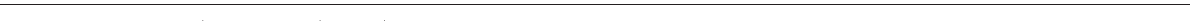
FIGURE 3 | Ly6G − F480 + CD11c − Ly6C + MHC II + cells (A–C) . The total number of neutrophils (D) , inflammatory monocytes (E) , and infiltrating macrophages (F) from days 1 and 3 were calculated according to their percentages of the total population and the total number of cells collected in each lung. @ denotes P ≤ 0.05 between coinfected and uninfected groups. # denotes P ≤ 0.05 between coinfected and influenza groups. * denotes P ≤ 0.05 between coinfected and K. oxytoca groups. Data were analyzed with ANOVA followed by Tukey’s multiple comparison tests. Error bars represent SEM. Data are combined from at least four independent experiments with at least four mice per